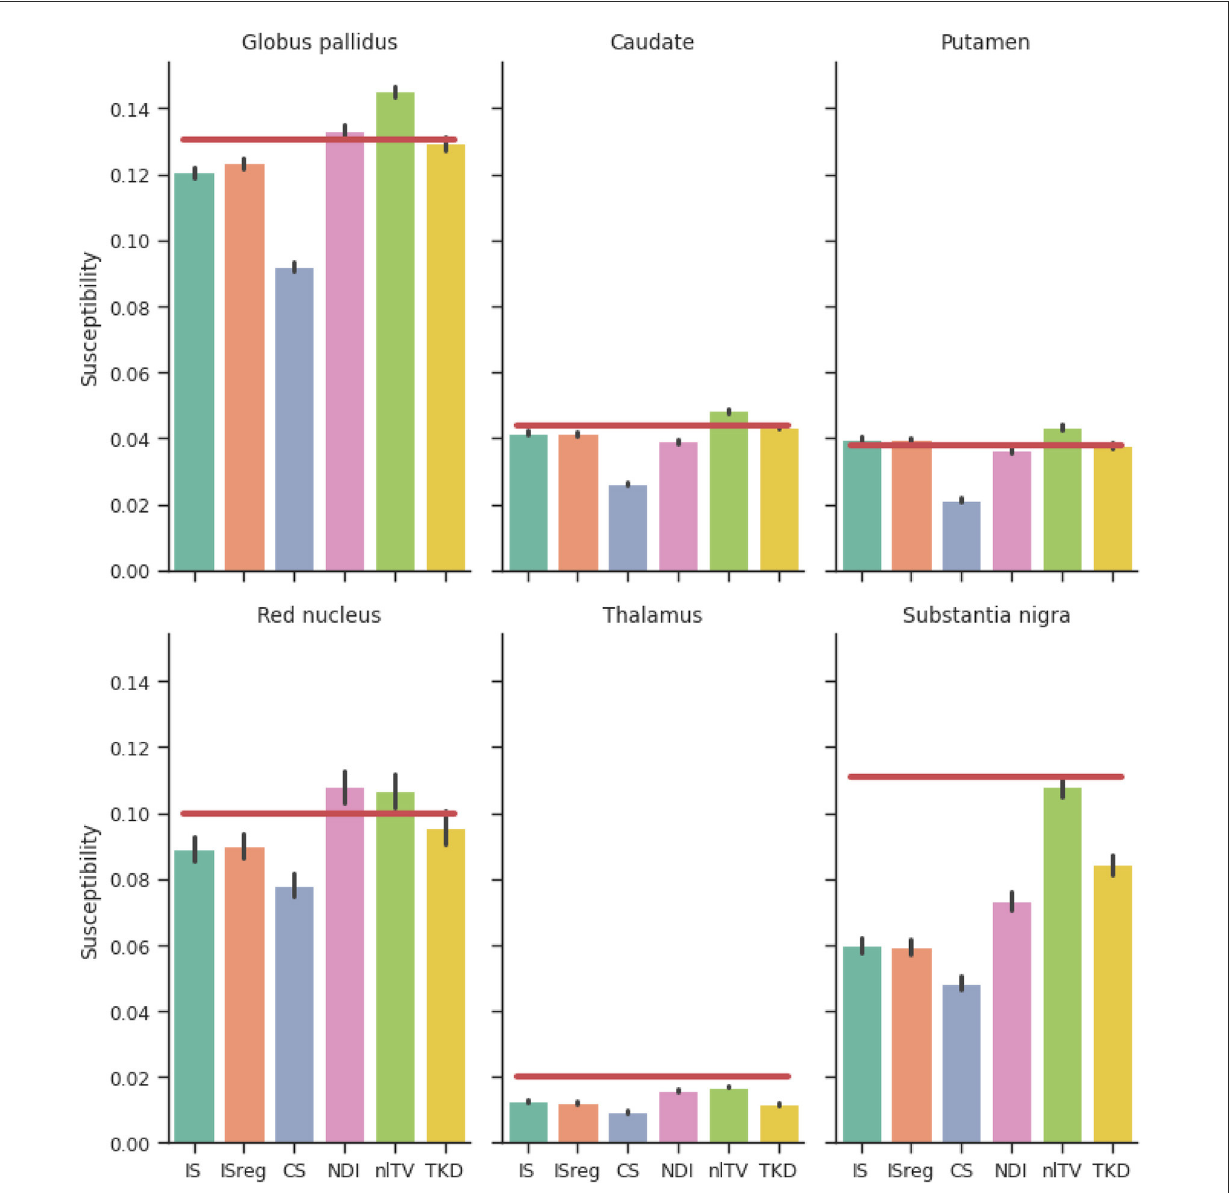
FIGURE6 Reconstructed susceptibility values of the simulated dataset for deep gray matter regions of interest. Red lines are ground truth susceptibility values, and vertical black lines signify 3 standard errors. IS, Incomplete spectrum ( t well = 0.25); ISreg, Regularized IS (Same parameters as IS & CS); CS, = 1 · 10 − 5 ); NDI, Nonlinear Dipole Inversion (w. automatic stopping); FANSI, Fast Nonlinear Susceptibility Compressed sensing ( 9 : Daubechies 2, λ ℓ 1 Inversion ( λ TV = 1 · 10 − 5 ); TKD, Thresholded k-space division ( λ = 2 / 3; w. PSF